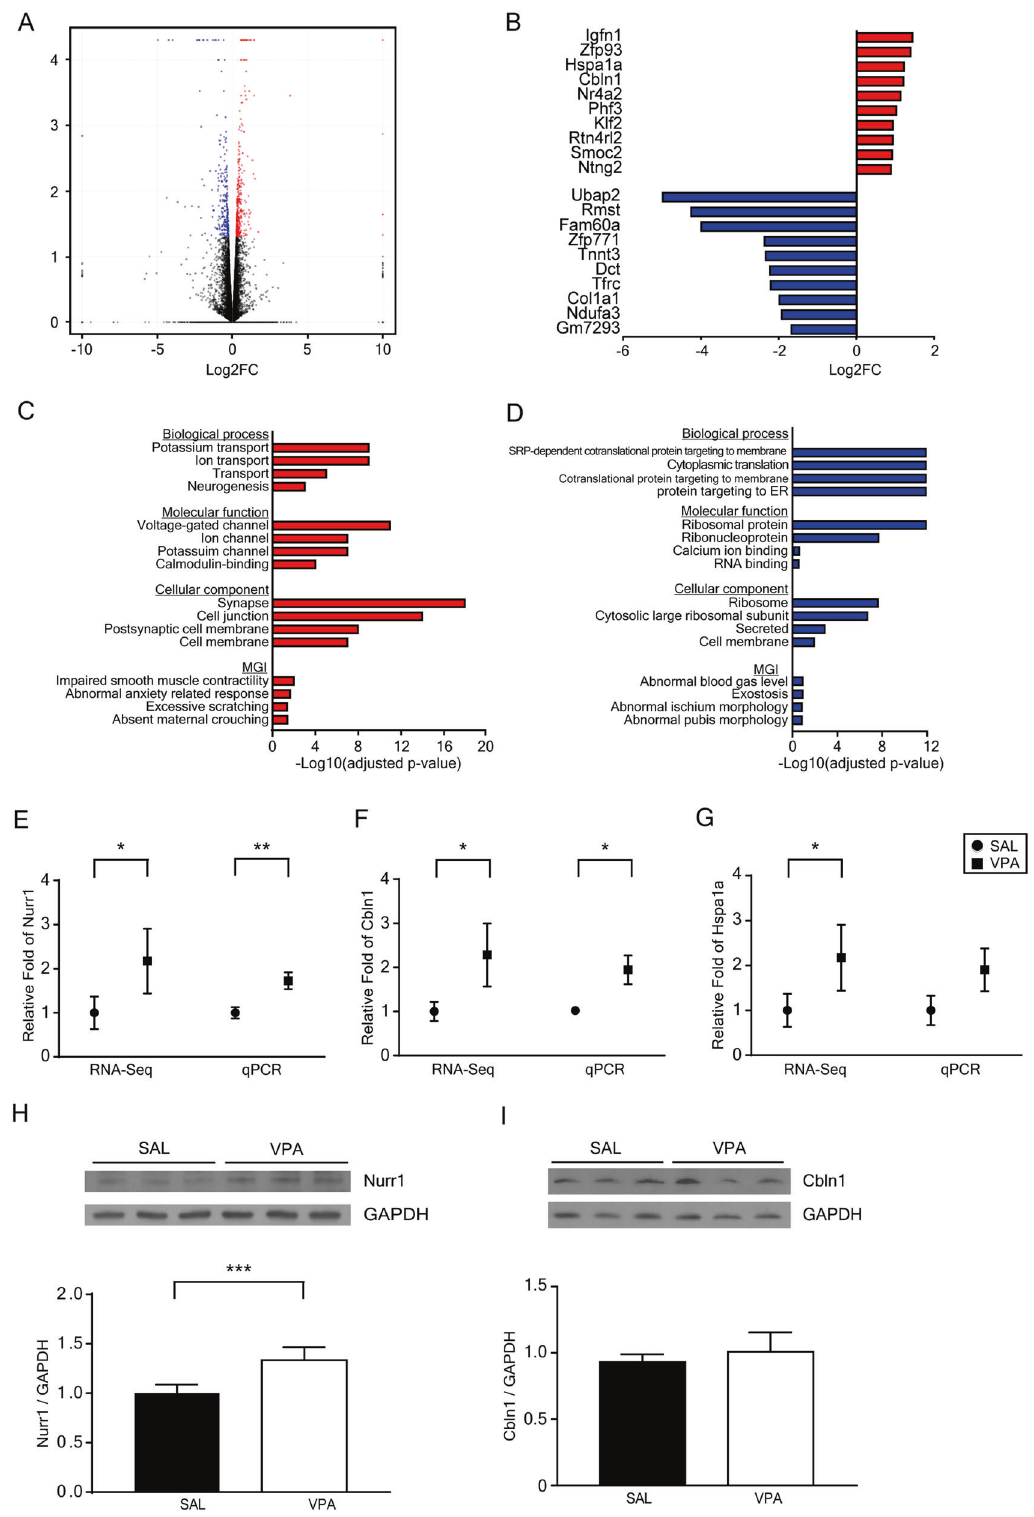
Fig. 2 Striatal transcriptome analysis of prenatally VPA-exposed 10-week-old mice. A Volcano plot depicting 348 signi fi cantly upregulated and 258 signi fi cantly downregulated genes (log2-fold change). B List of the top 10 upregulated and downregulated differentially expressed genes (based on the fold change) from the RNA-Seq analysis. C , D GO and mouse genome informatics mammalian phenotype analysis of the upregulated genes and downregulated genes. E – G mRNA expression of Nurr1 (SAL, n = 9; VPA, n = 9), Cbln1 (SAL, n = 11; VPA, n = 11), and Hspa1a (SAL, n = 7; VPA, n = 8) in the prenatally VPA-exposed striatum determined by RNA-Seq and qPCR. compared to SAL mice. H , I Representative blots for Nurr1 and Cbln 1 and densitometric analysis of protein levels of Nurr1 (SAL, n = 12; VPA, n = 12) and Cbln1 (SAL, n = 18; VPA, n = 18) in the striatum of VPA mice * p < 0.05, ** p < 0.01, *** p < 0.001 compared to SAL mice, unpaired t -test, or Mann – Whitney